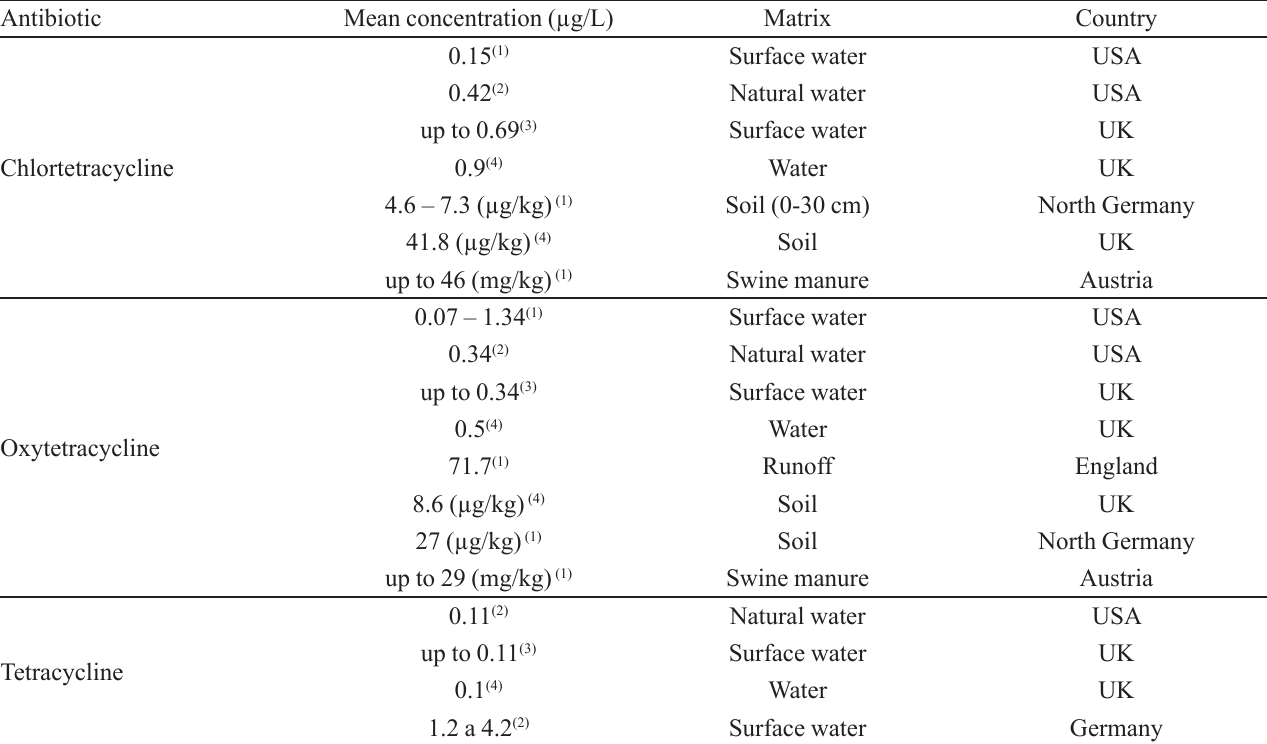
TABLE IV - Environmental concentration of antibiotics of the tetracycline family